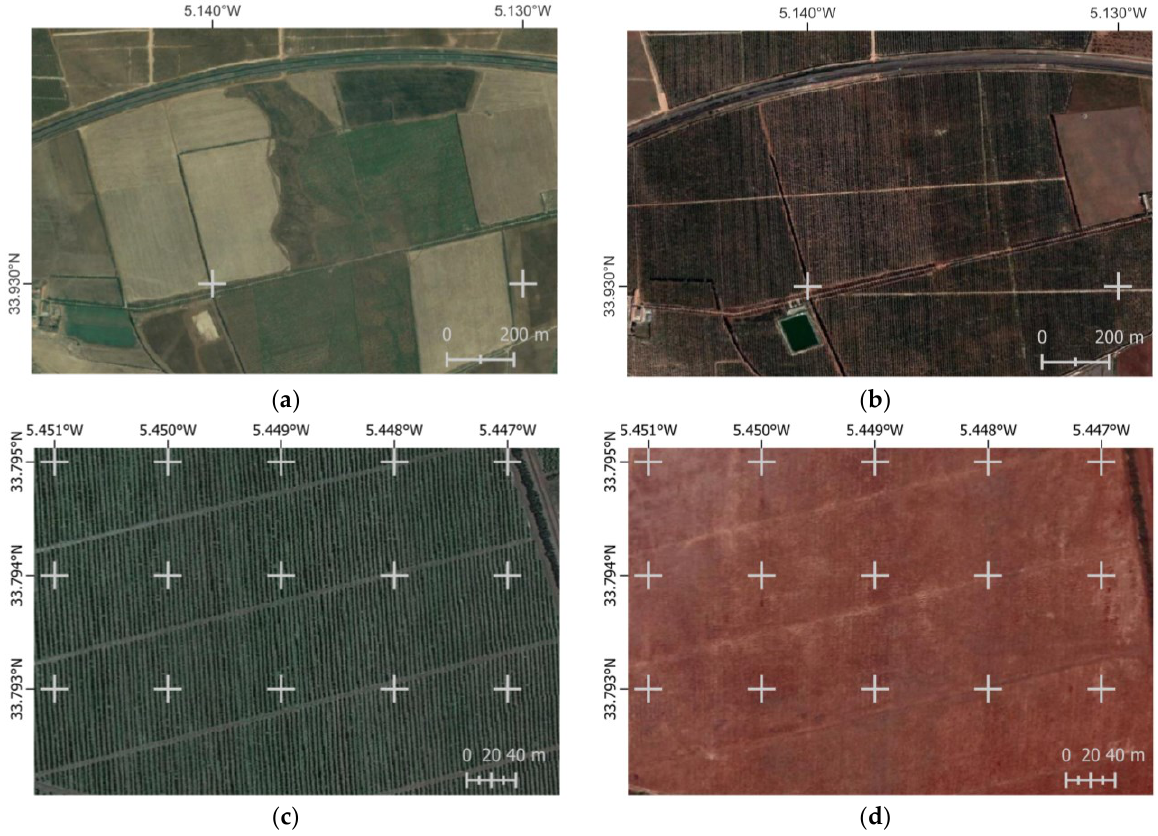
Figure 15. Land use changes from annual crops in 2010 ( a ) to SHD olive plantations in 2020 ( b ), and from SHD olive plantations in 2020 ( c ) to annual crops in 2011 ( d ). Source: Google Earth Images 2020.